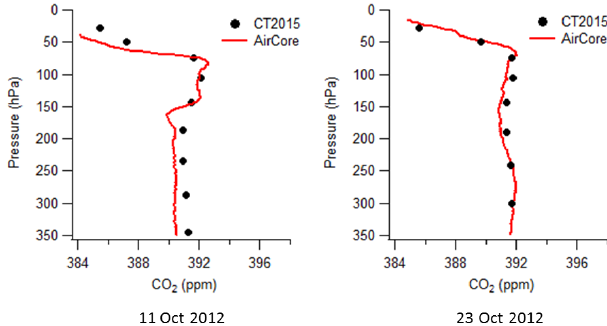
Figure 2. CarbonTracker (CT2015) simulations compared with Air- Core in situ measurements in the upper atmosphere. AirCore pro- files in the left and right panels are sampled near CAR and SGP, respectively.